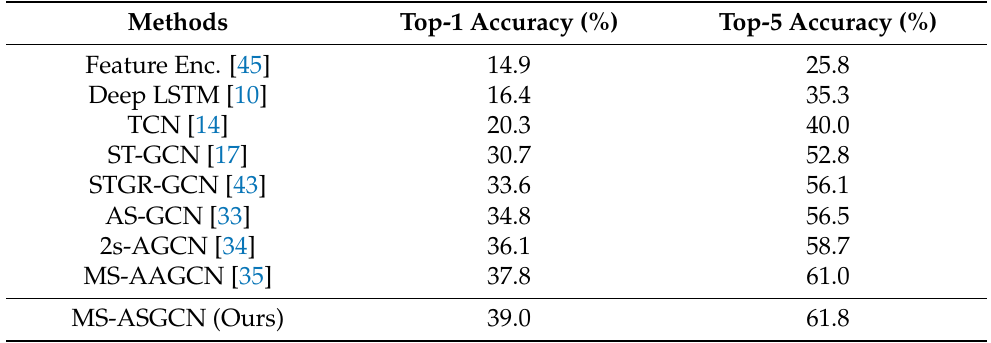
Table 8. Comparison of action recognition accuracy with state-of-the-art methods on the Kinetics- Skeleton dataset. Both top-1 and top-5 accuracies are